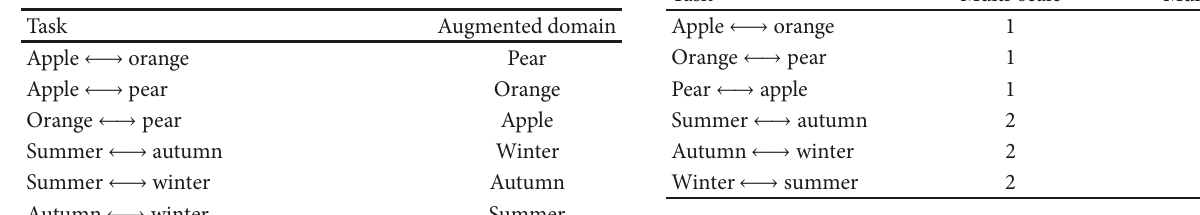
Table 2: Experiment settings. Image translation between apple and orange, we add images of the pear domain, namely, apple2orange or orange2apple. Others are similar.